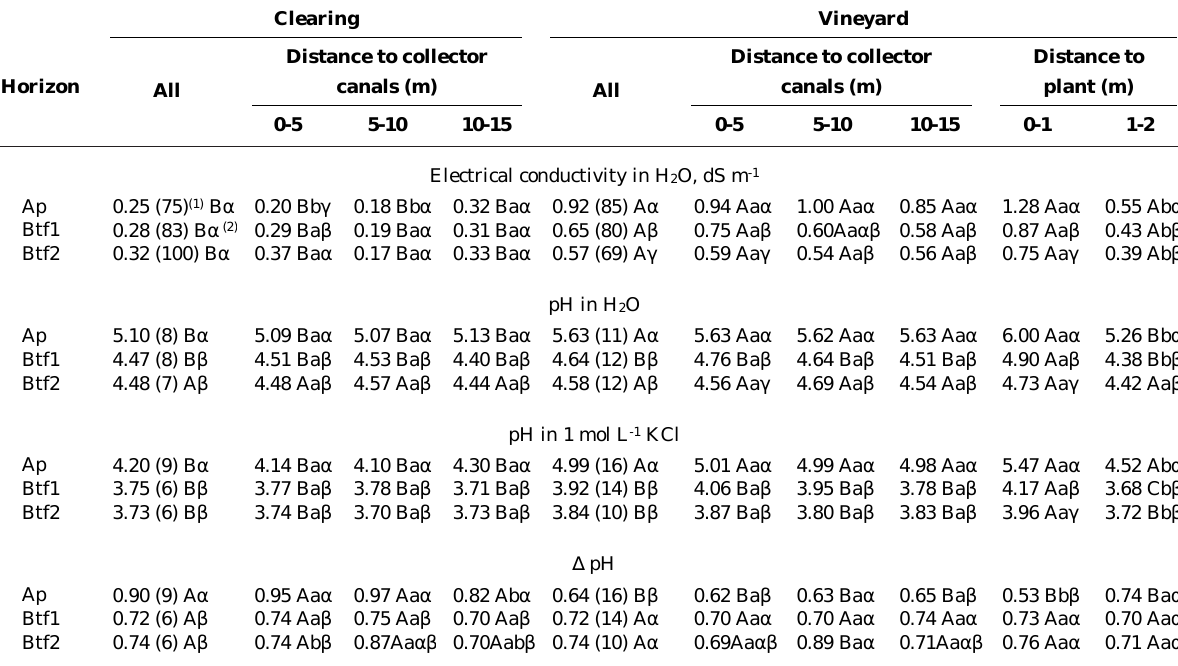
(1) Numbers in parentheses represent coefficients of variation. (2) Capital letters compare sub-areas; small letters, distances to grapevines; and Greek letters,